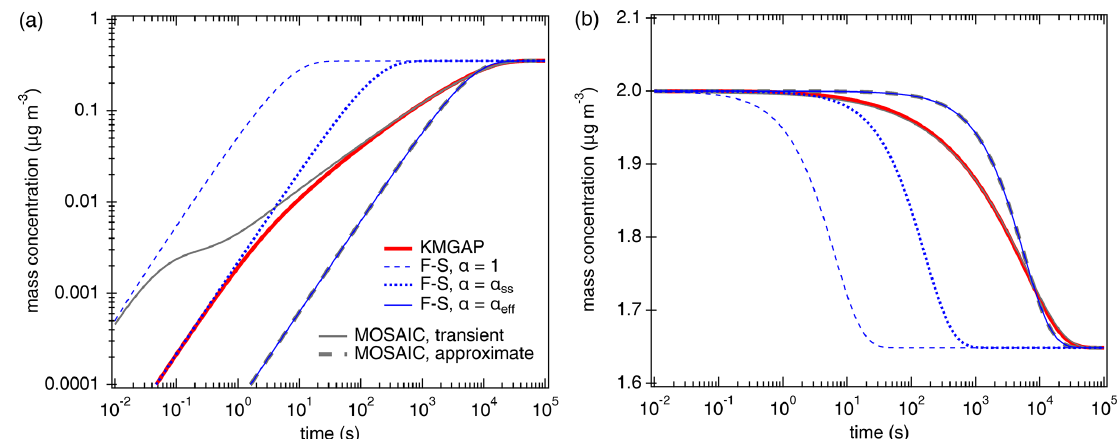
Figure 1. Temporal evolution of the particle-phase concentration (a) and the gas-phase concentration (b) of semi-volatile organic compounds (SVOC, C 0 = 100µgm − 3 ) interacting with semi-solid seed aerosol particles ( D b = 10 − 15 cm 2 s − 1 , ω = 2 × 10 4 cms − 1 , ρ p = 1gcm − 3 ). The red lines are simulation results of KM-GAP, and the blue lines are the results of an aerosol dynamic model that employs the Fuchs– Sutugin approximation with α = α s = 1 (dashed), α = α ss = 3 × 10 − 2 (dotted), and α = α eff = 8 × 10 − 4 (solid). The gray lines represent the MOSAIC transient solution (solid) and approximate solution (dashed) (Zaveri et al., 2014).